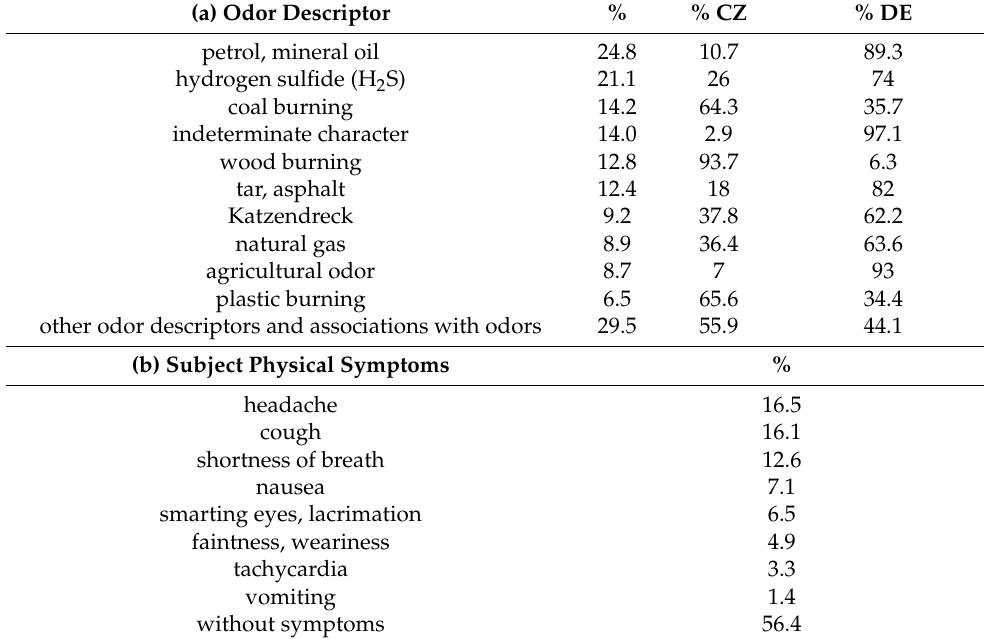
Table 2. Percentage of records with (a) characteristic odor or (b) physical symptom item ( n = 491). For characteristic odors, the percentage reported in either the Czech Republic or Germany are shown. Total percentages for subjective odor descriptors and physical symptoms are greater than 100% because of multiple reporting of odors or symptoms by